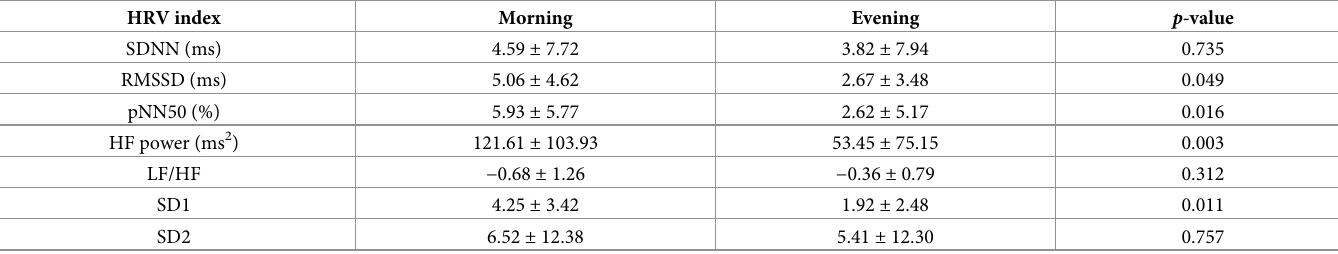
Table 3. Changes and statistical significance of different HRV indicators between the morning and evening groups. HRV index